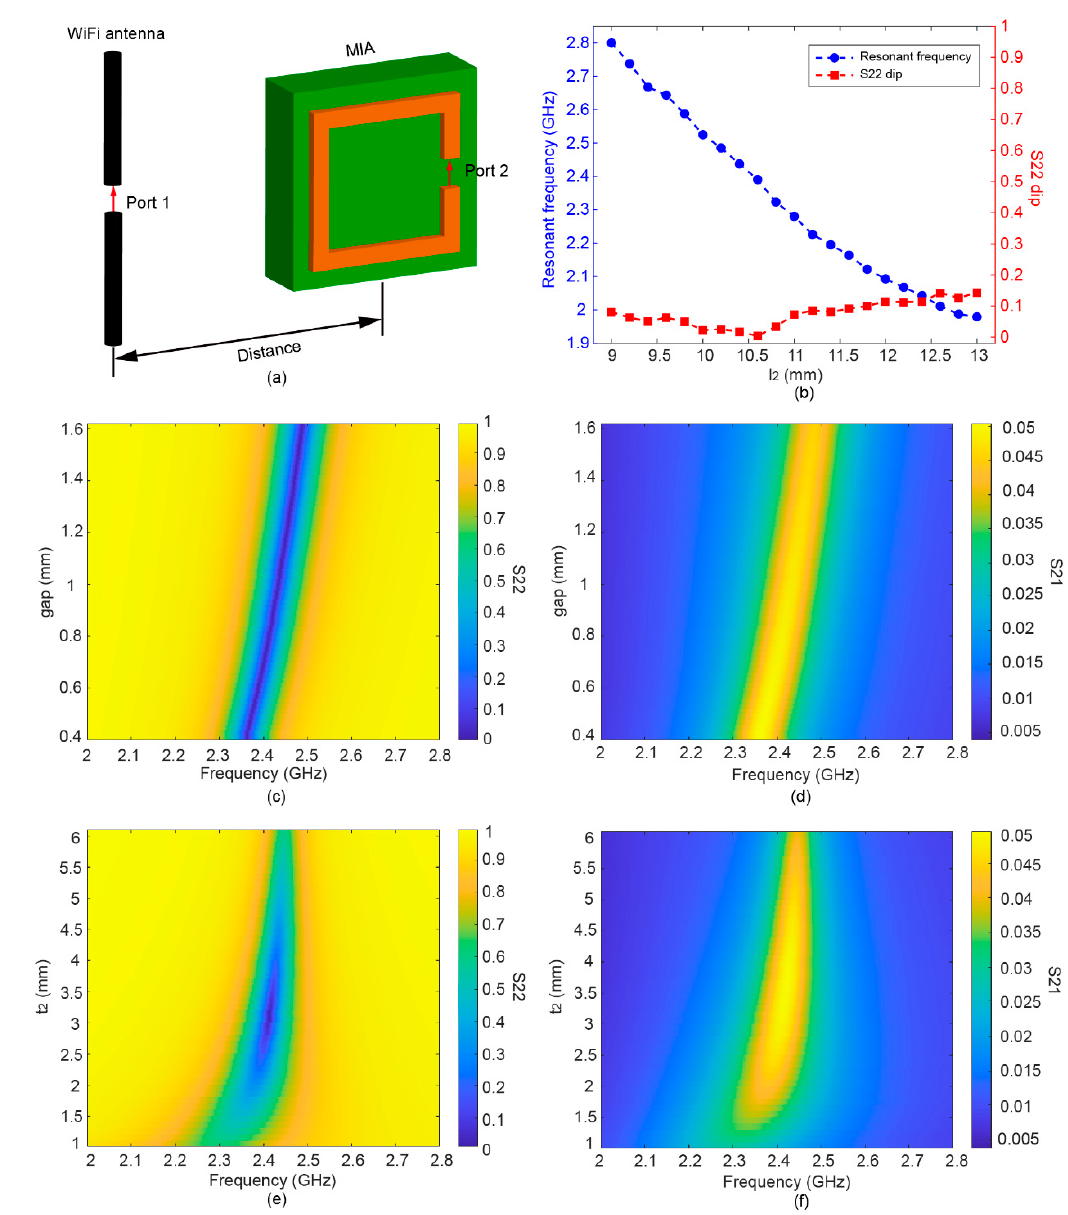
Figure 2. ( a ) The simulation model to analyze the RF characteristics of the MIA. ( b ) Simulated minimum of the reflection coefficient of the MIA, i.e., minimum of S22, and resonant frequency of the MIA versus length of SRR ( l 2 ). ( c ) Simulated S22 and ( d ) transmission coefficient (S21) versus the gap of SRRs ( gap ). ( e ) Simulated S22 and ( f ) S21 versus thickness of FR4 substrate ( t 2 ). In addition to the side length, the gap of SRRs is another parameter that affects the resonant frequency. As depicted in Figure 2c, the resonant frequency increase from 2.34 to 2.49 GHz when the gap of SRR is changed from 0.4 to 1.6 mm. The reflection amplitude at the resonant frequencies is almost constant for various gap sizes, indicating that the gap